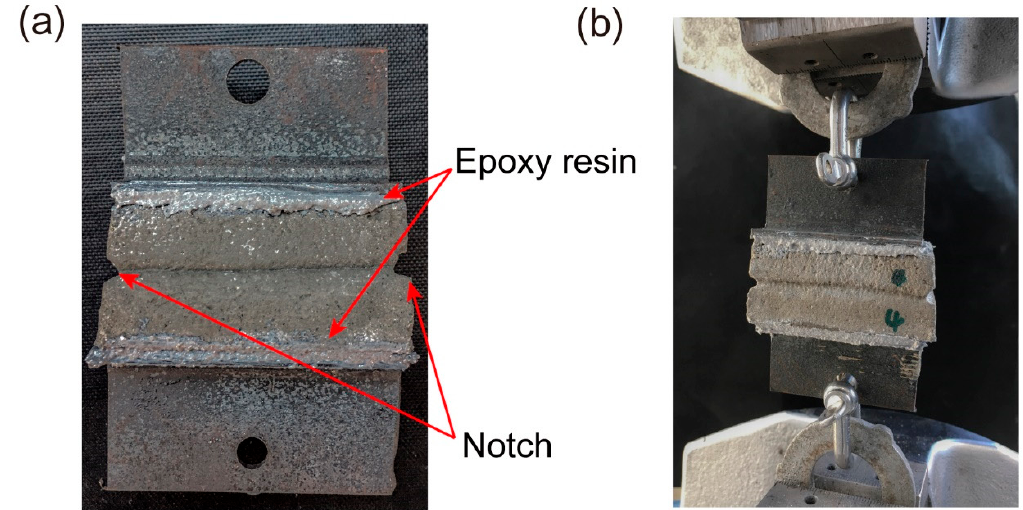
Figure 6. ( a ) Specimen prepared for interlayer bond test. ( b ) Test setup for interlayer bond